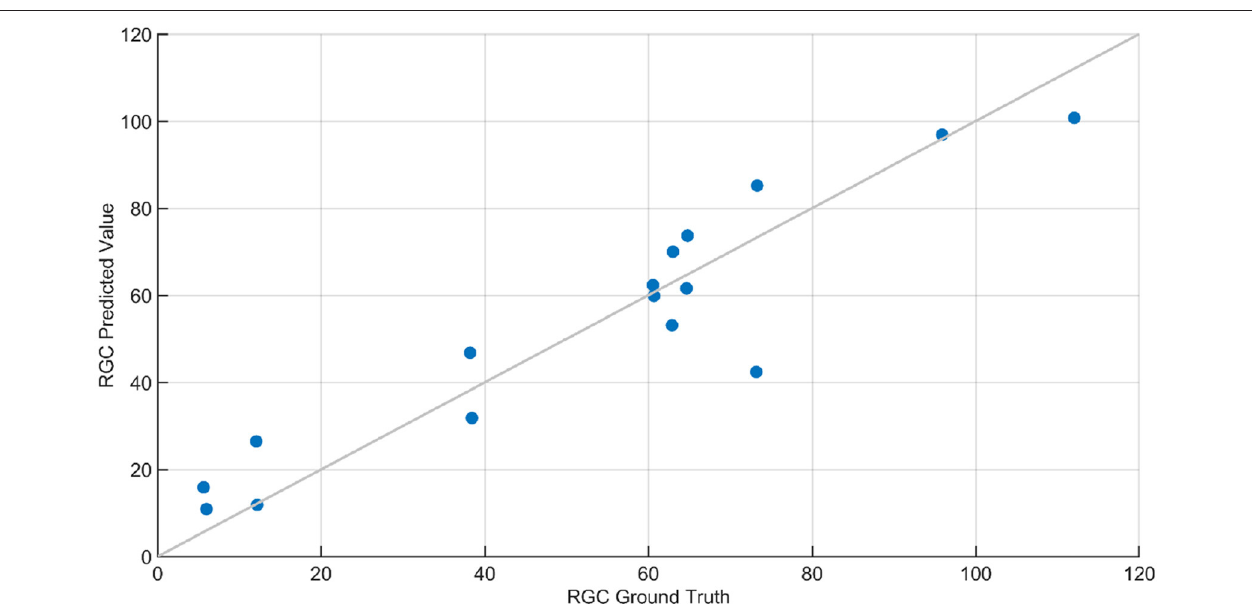
FIGURE 10 | RGC count regression plot. This plot contains the ground truth and predicted response of RGC count predicted using Gaussian Process Regression (GPR). The squared exponential GPR model was trained using both standard and advanced features. The RGC count of the animals ranged between 8 and 120, and the root mean squared error in the prediction of RGC was 11.2. The line in this plot denotes when the predicted values are equal to ground truth values.